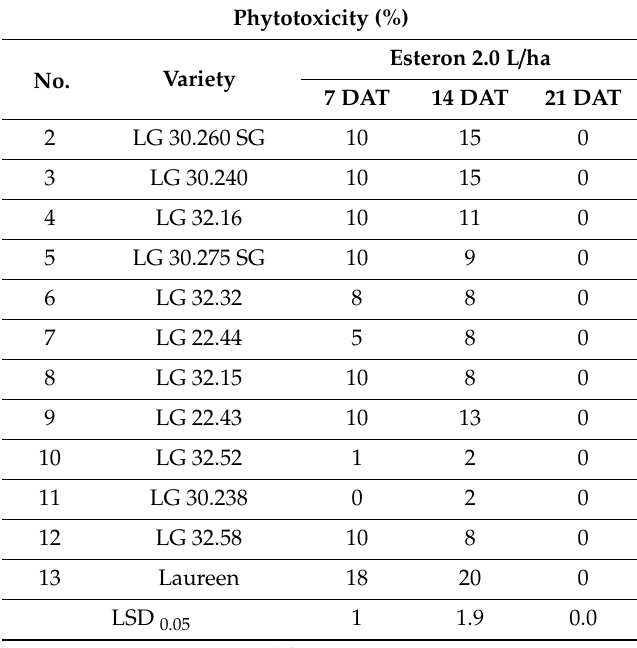
Table 4. Sensitivity of maize varieties to the herbicide Esteron 600 EC (2,4-D)